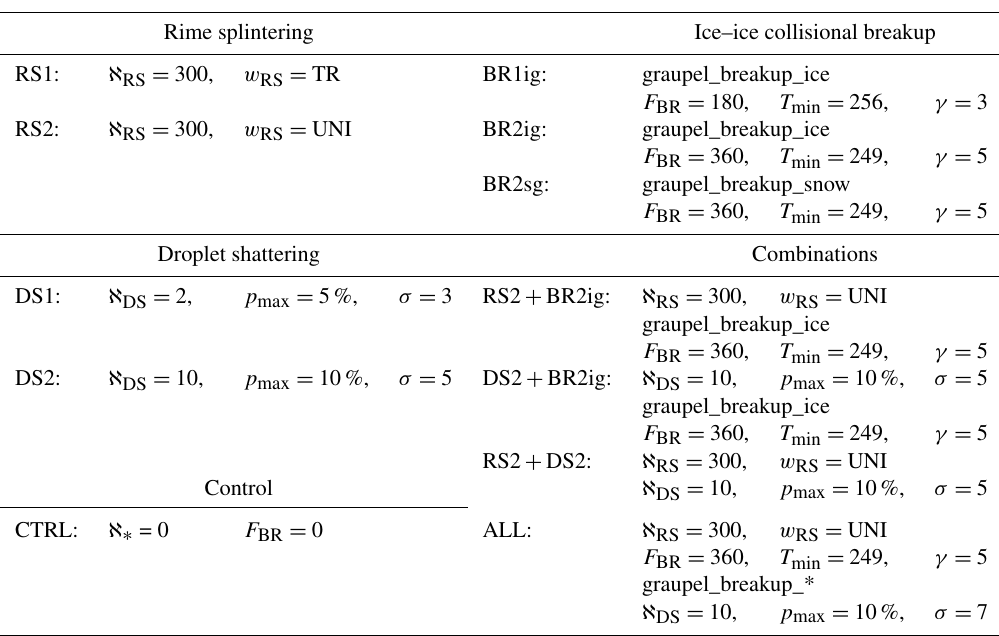
Table 1. New subroutines in the two-moment scheme, containing the ice hydrometeor collision parameterizations, given as col- lider_breakup_collided. ice crystals snow graupel hail ice crystals graupel_breakup_ice hail_breakup_ice snow graupel hail